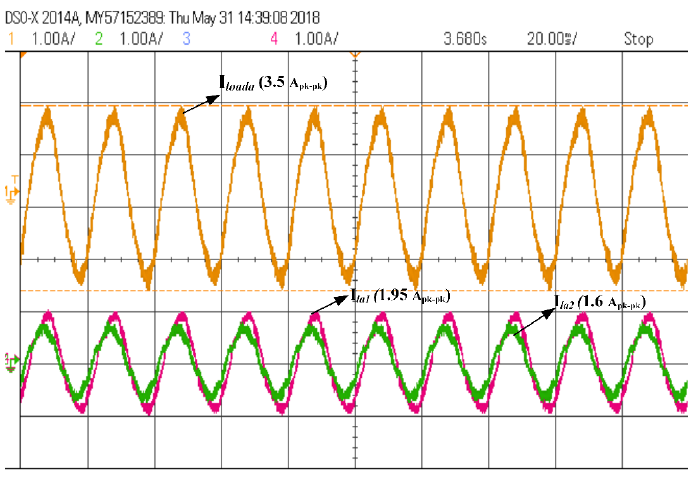
Figure 20. Output current of Inverter-1, Inverter-2 and load.